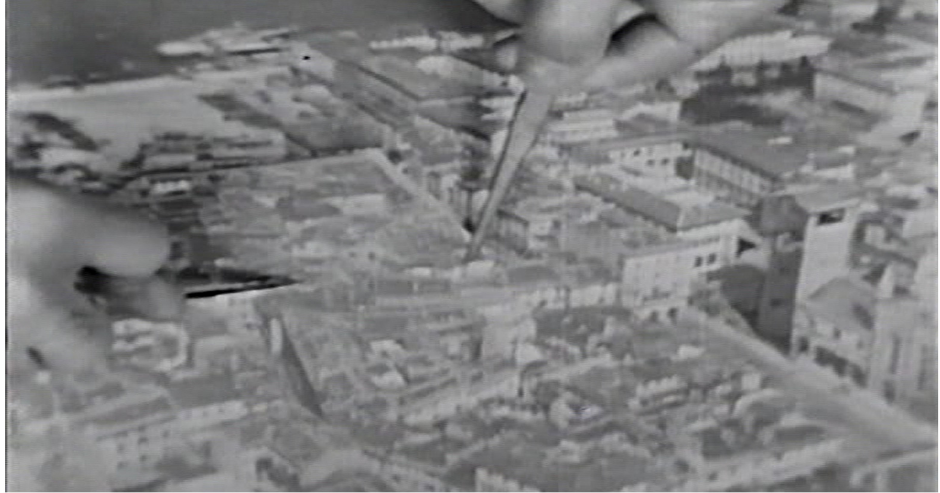
Figure 4. The removal of the Como’s central neighborhood named Cortesella with a surgical knife as shown in the movie directed by Ico Parisi in